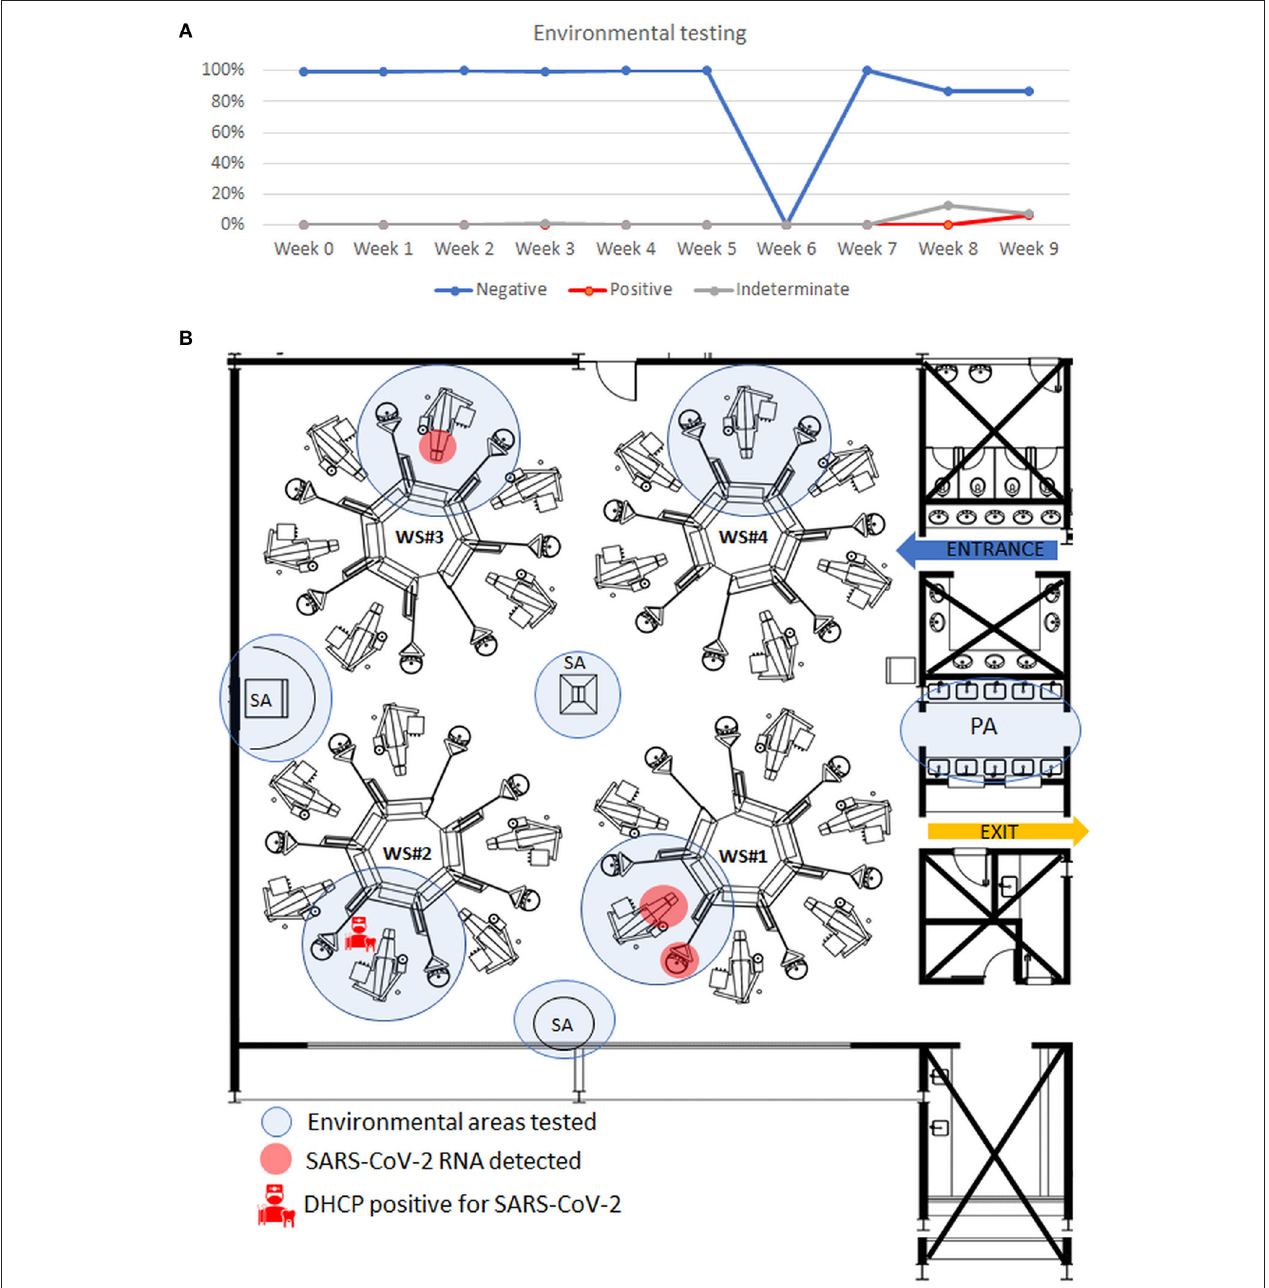
FIGURE 4 | Results of environmental samples collected from the dental clinic and tested by RT-qPCR. (A) Graphic representation of the results of environmental samples per week. Values in percentage. (B) Representative figure, on week 9, showing the spatial distribution of areas positive for SARS-CoV-2 RNA, detached in red, and position of the detected positive dental health professional in the workstation#2 in the clinic. Workstation #1 presented detected (the sink bench, detergent dispenser, dental chair upholstery, light handle, and light arm) and indeterminate results (non-hazardous waste disposal, air sample, and saliva ejector hose–external part). The workstation #3 presented one sample positive in the light arm and presented indeterminate results in the other three spots. WS, workstation. DHCP, dental health care professional. PA, Purge area. SA, supporting